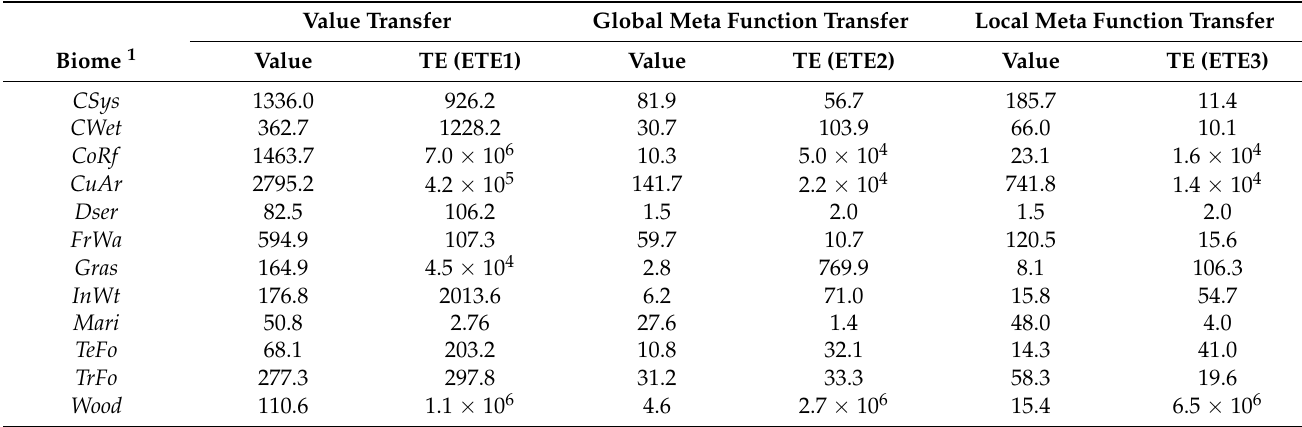
Table 6. Comparison of values and transfer errors (TE) per biome for Provisioning ES, based on Value transfer, Global meta function transfer, and Local meta function transfer (in 2015 € /ha/yr).